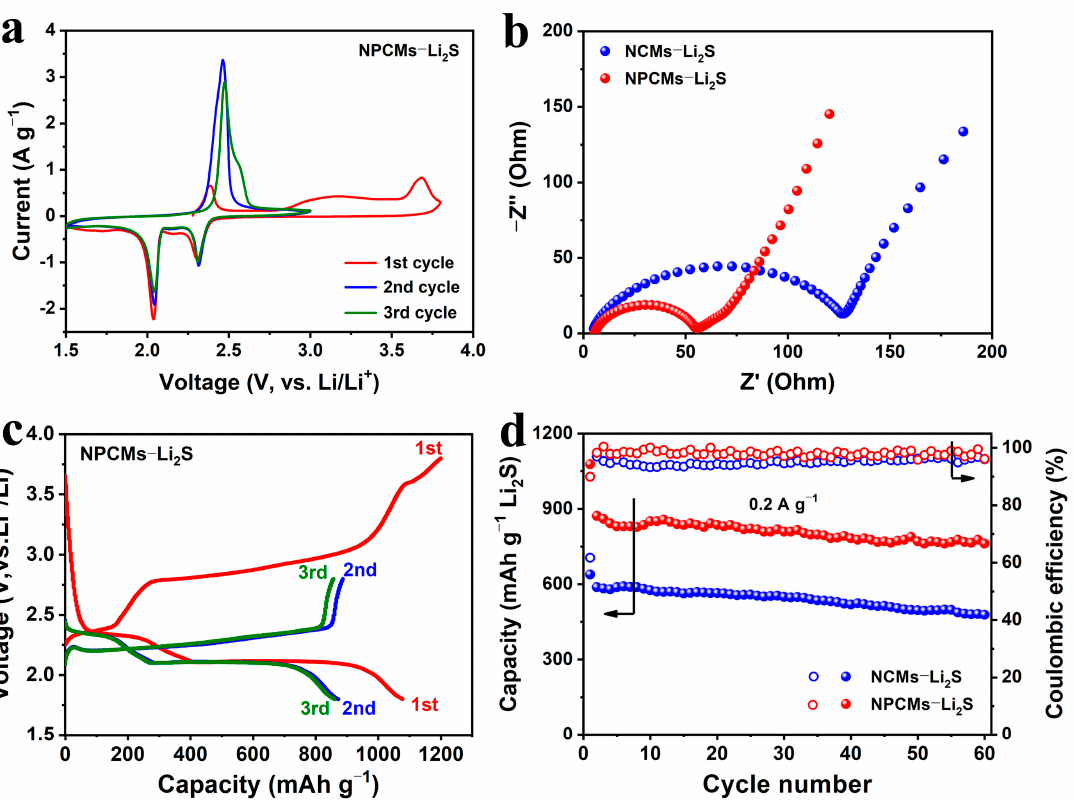
Figure 4. ( a ) CV curves of NPCMs–Li 2 S cathode; ( b ) EIS spectra of NPCMs–Li 2 S and NCMs–Li 2 S electrodes in the fresh state; ( c ) charge–discharge profiles of the NPCMs–Li 2 S cathode in the first three cycles; ( d ) cycling performance of NPCMs–Li 2 S and NCMs–Li 2 S electrodes at 0.2 A g − 1 .